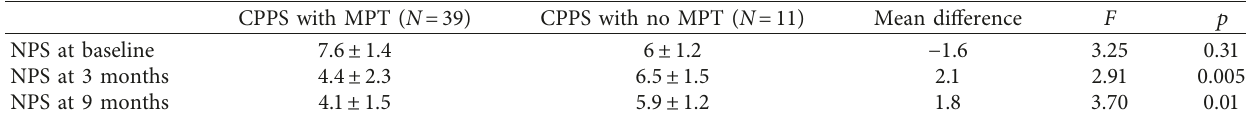
Table 4: Differences in pain scores (after 3 and 9 months) of women with CPPS who received MPTcompared with women with CPPS who did not receive MPT.